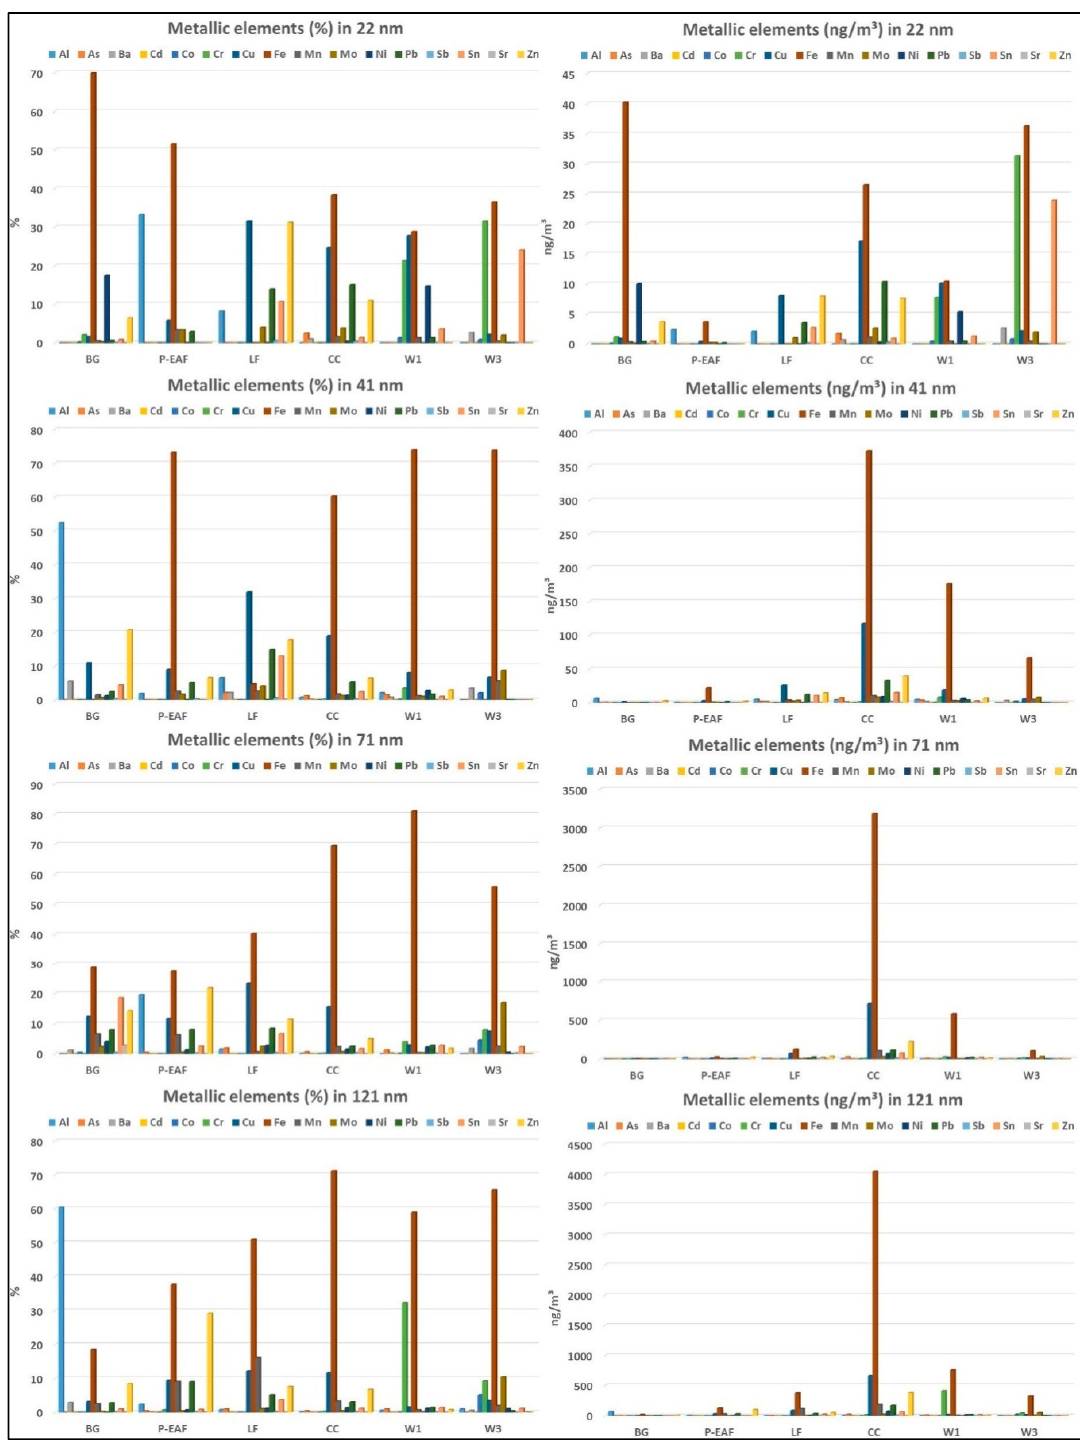
Figure 6. Distribution of the metallic elements (percentage value ( left ) and ng/m ³ ( right ) for each fraction) in the different UFP size ranges collected by ELPI+, for each area and working station. The percentages shown in the figure represent the fraction of each metallic element on the total of the metallic elements determined in each size range for each sampling site.